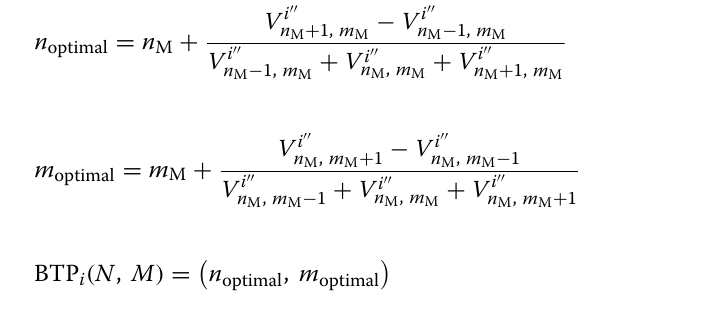
m 1 , . . . , m 1 m 2 , i = + − (cid:30)